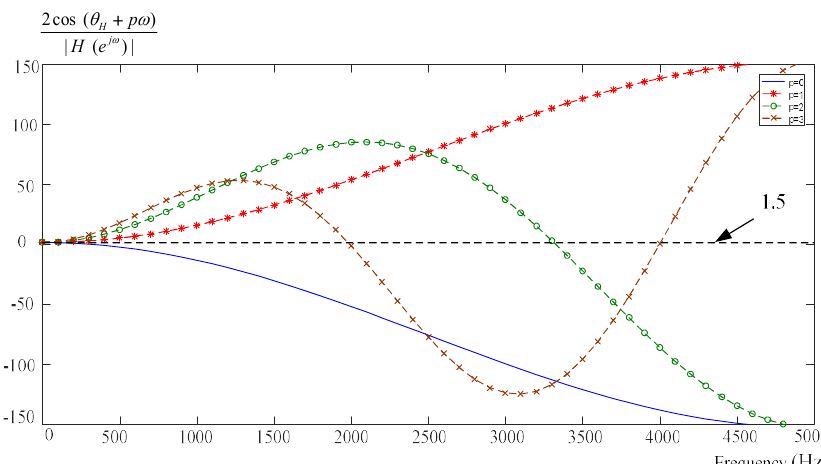
Figure 4. Compensated phase responses using a periodic controller.